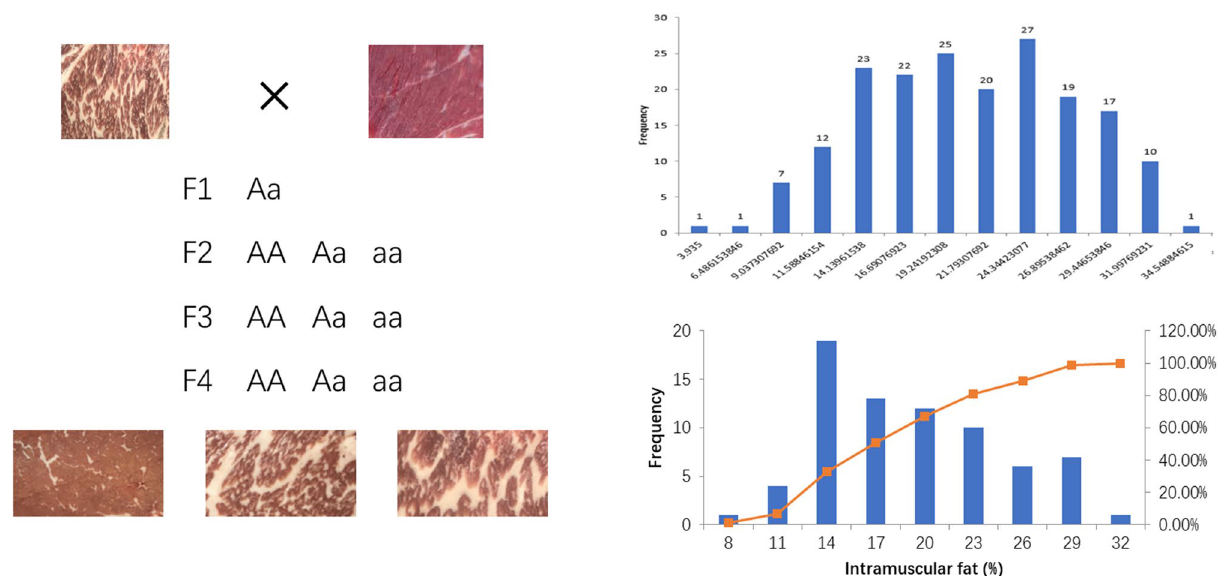
Figure 1. Population distribution of samples (left) and each sample frequency distribution of intramuscular fat